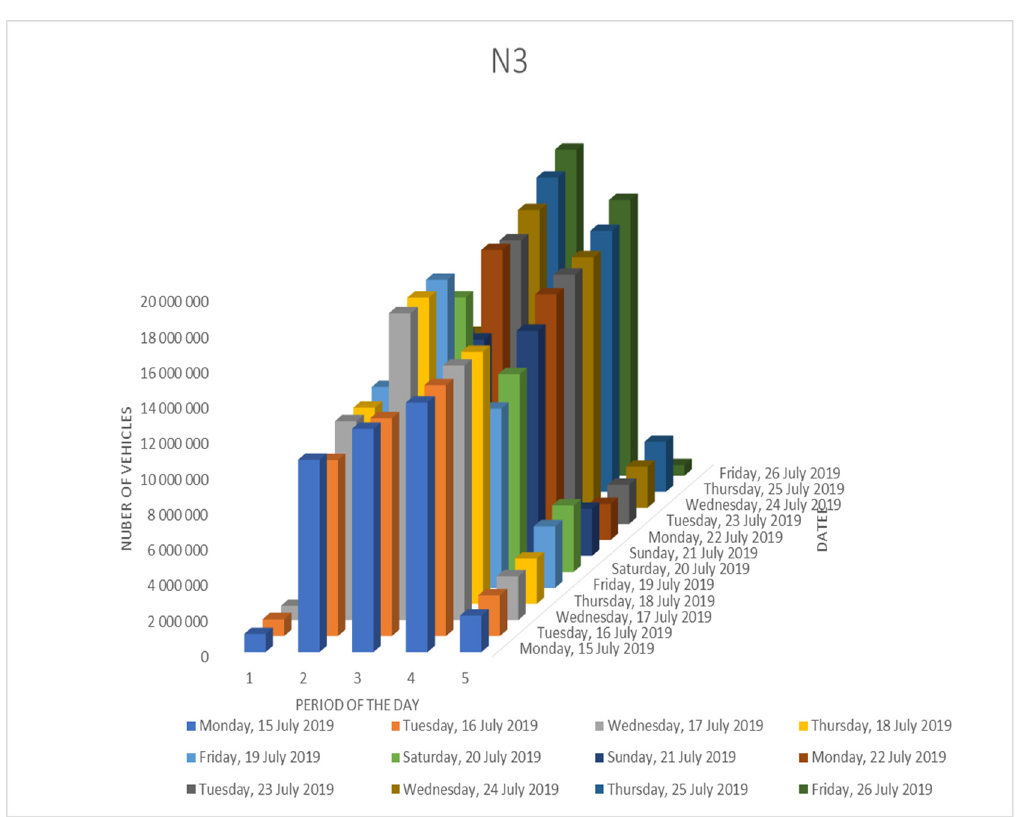
Figure A2. N3 Freeway